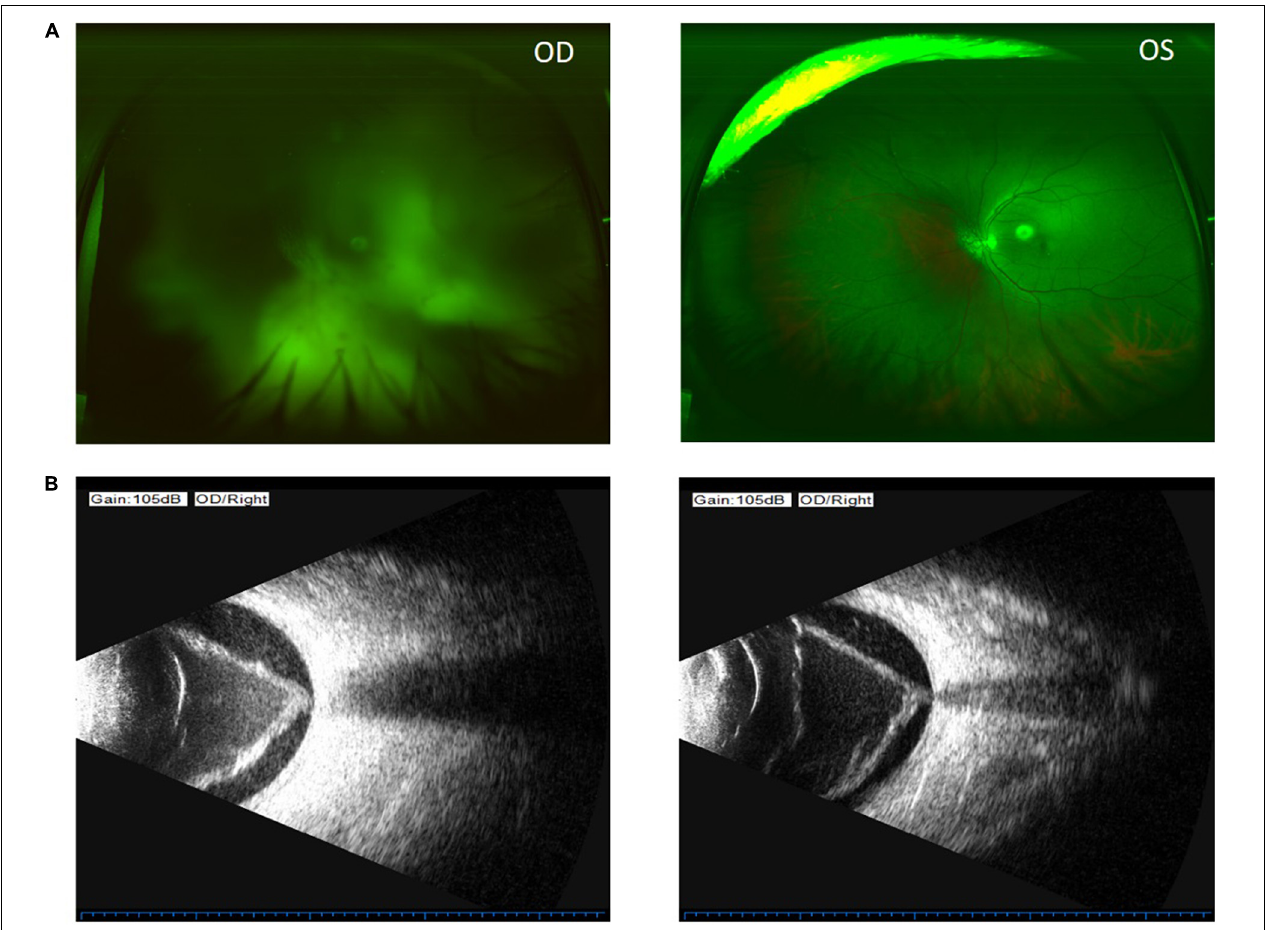
FIGURE 2 | Color funds photograph shows invisible fundus of the right eye (upper left) and no fundus pathology of the left eye (upper right) (A) . Ocular B-ultrasound of the right eye shows vitreous opacity, vitreous membranes, and retinal detachment in the right eye (lower left and lower right) (B) .